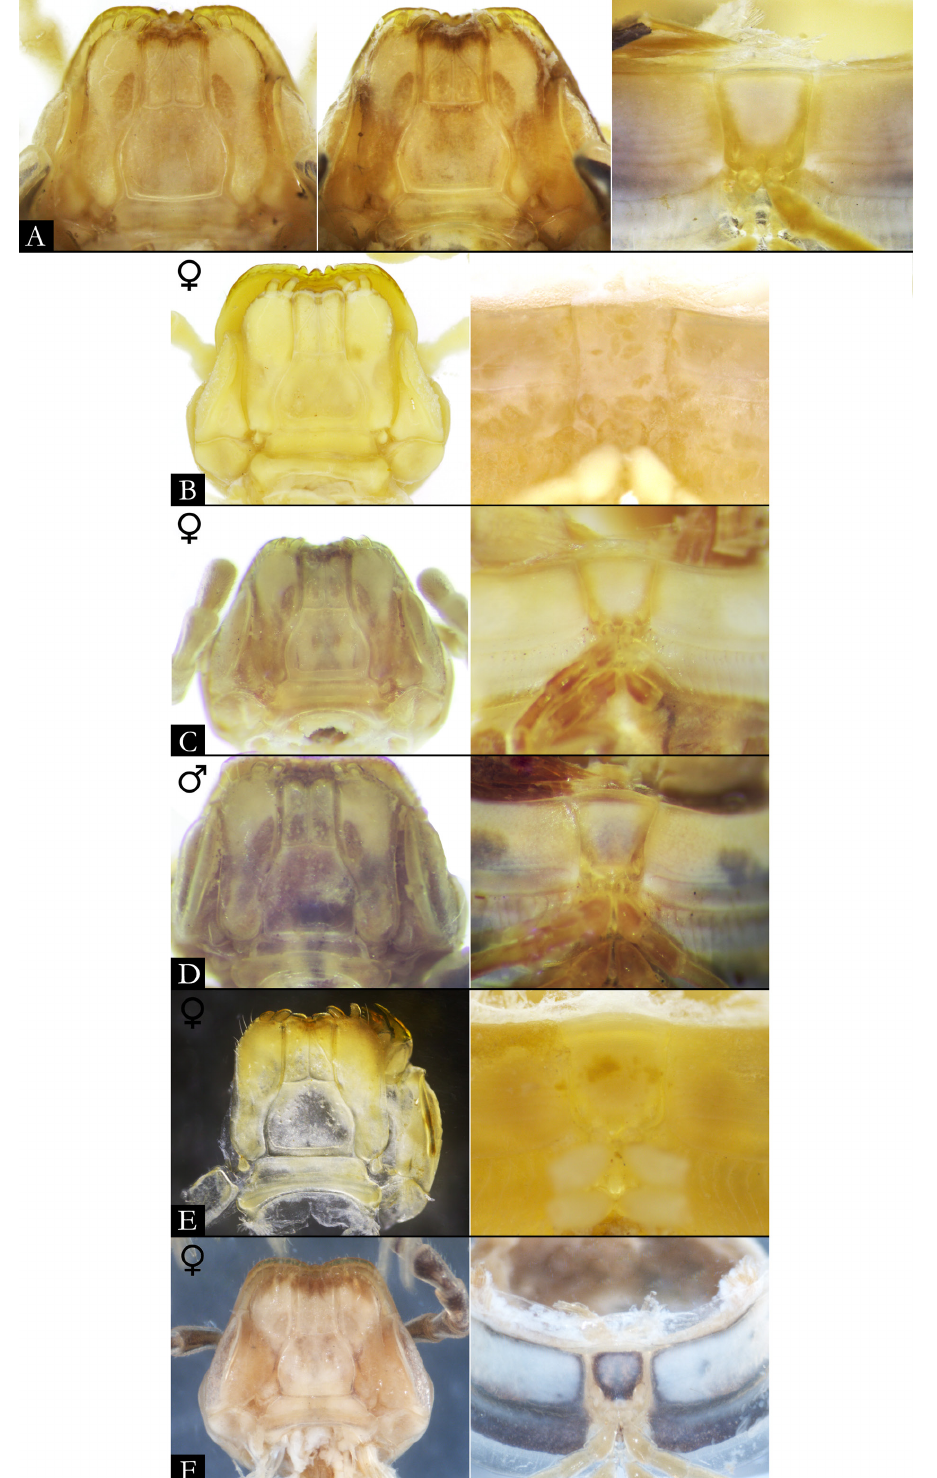
Fig. 176. Stereoscopic images of gnathochilarium and anterior sternum of species of